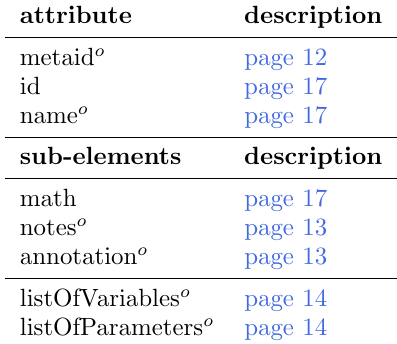
Table 2.21: Attributes and nested elements for dataGenerator. o denotes optional elements and